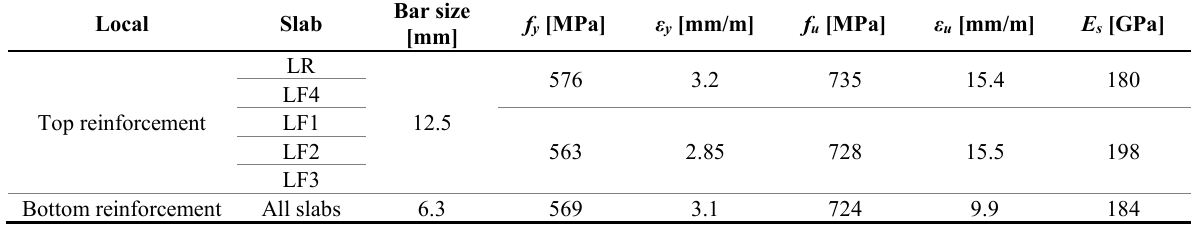
Table 2. Mechanical properties of reinforcement.